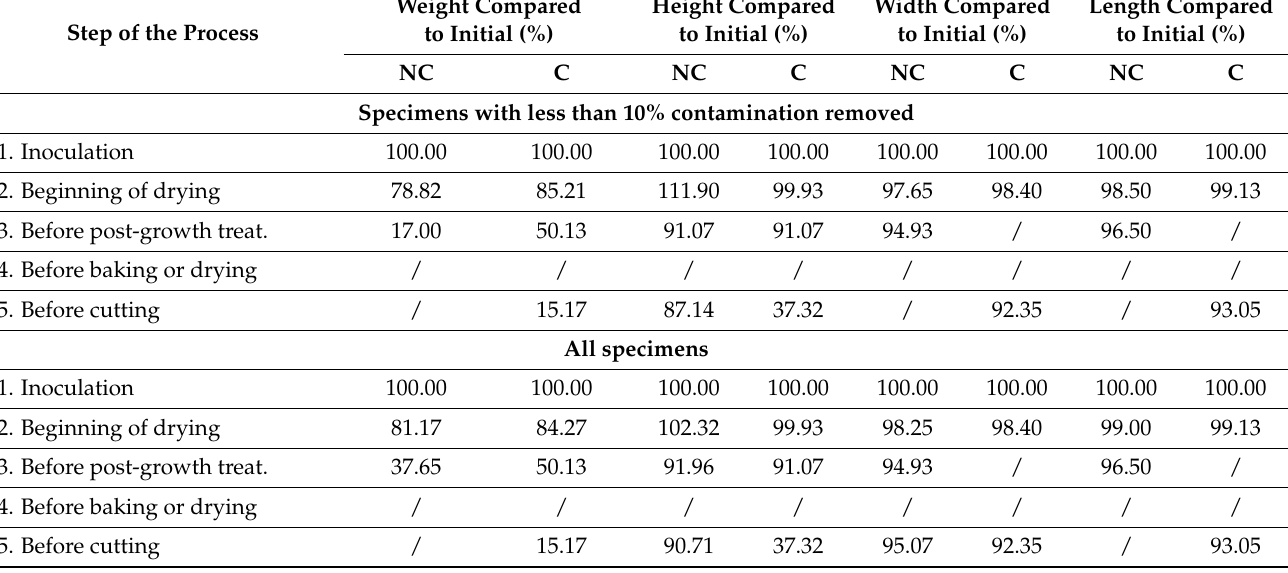
Table A2. This table shows the evolution of the weight, height, width, and length for the specimens grown for bending. Uncompacted (NC) and compacted (C) specimens were analyzed separately since compacted specimens were constrained in metal frames used for compaction. Weight Compared